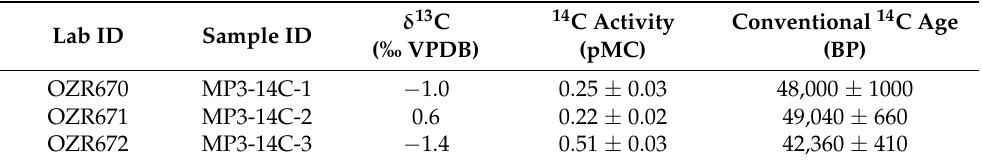
Table 2. Conventional 14 C ages of the youngest part of the MP-3 speleothem from Manita pe´c Cave uncorrected for the dead carbon fraction